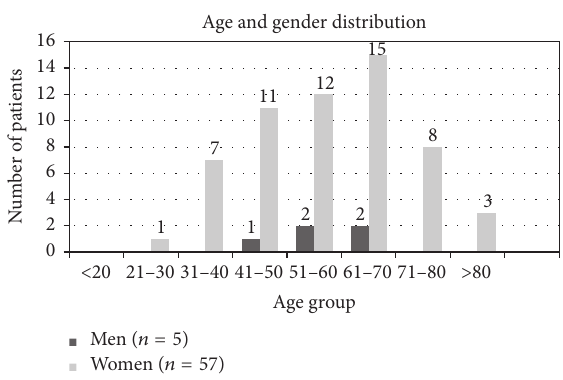
Figure1:Ageandgenderdistributionofthestudiedpopulation( 𝑛 = 62 ).